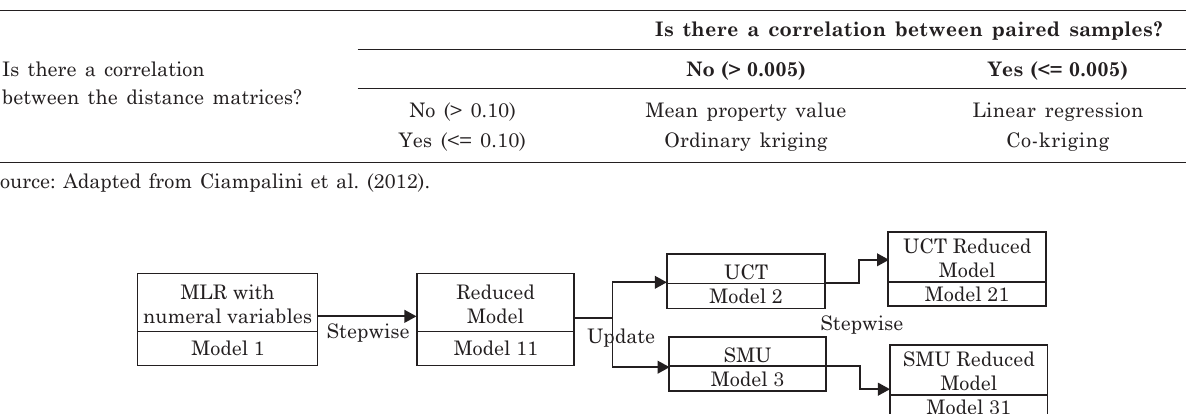
Table 3. Decision rules used to select the appropriate model for the prediction of soil properties